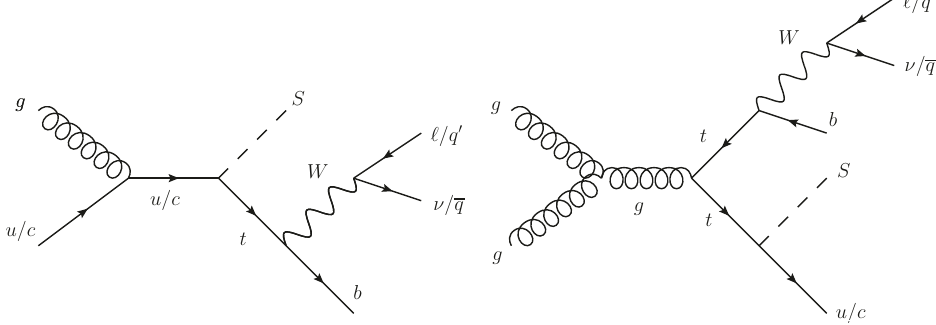
Figure 2 . Representative Feynman diagrams for the production of a single top quark in association with S via an FCNC interaction (left) and for the top-quark pair production with an FCNC top- quark decay into the extra singlet (right). Similar diagrams but involving two rather than one S in the new physics vertex hold for the production of a top quark in association with SS